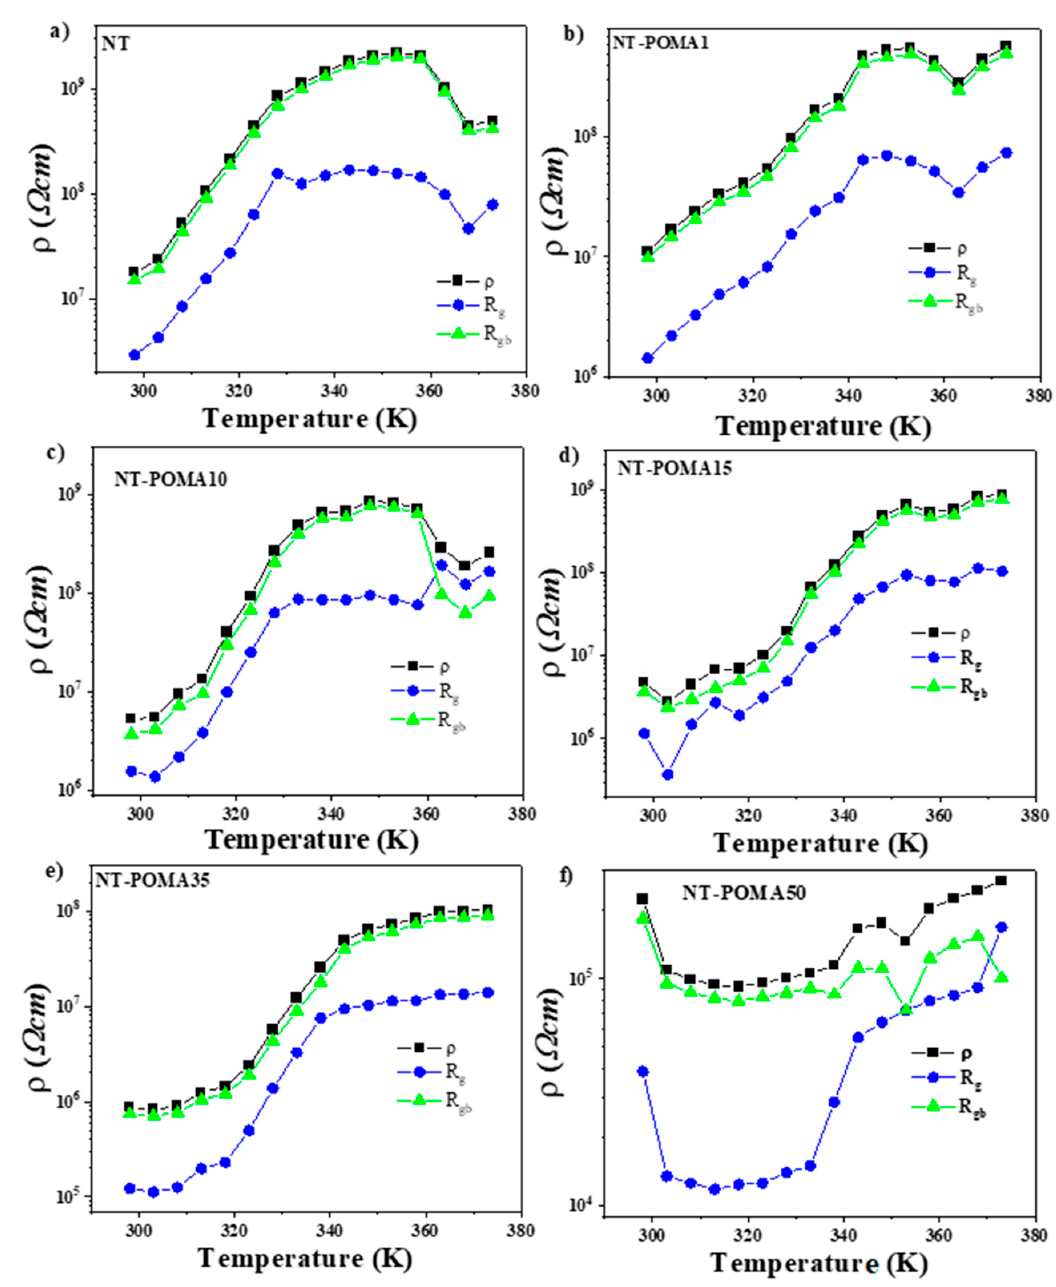
Figure 4. Temperature dependence of the total, grain and grain boundary resistivity for different compositions. ( a ) NT, ( b ) NT-POMA1, ( c ) NT-POMA10, ( d ) NT-POMA15, ( e ) NT-POMA35 and ( f ) NT- POMA50 samples correspond to 0.0%, 0.1%, 10%, 15%, 35% and 50% of POMA content,